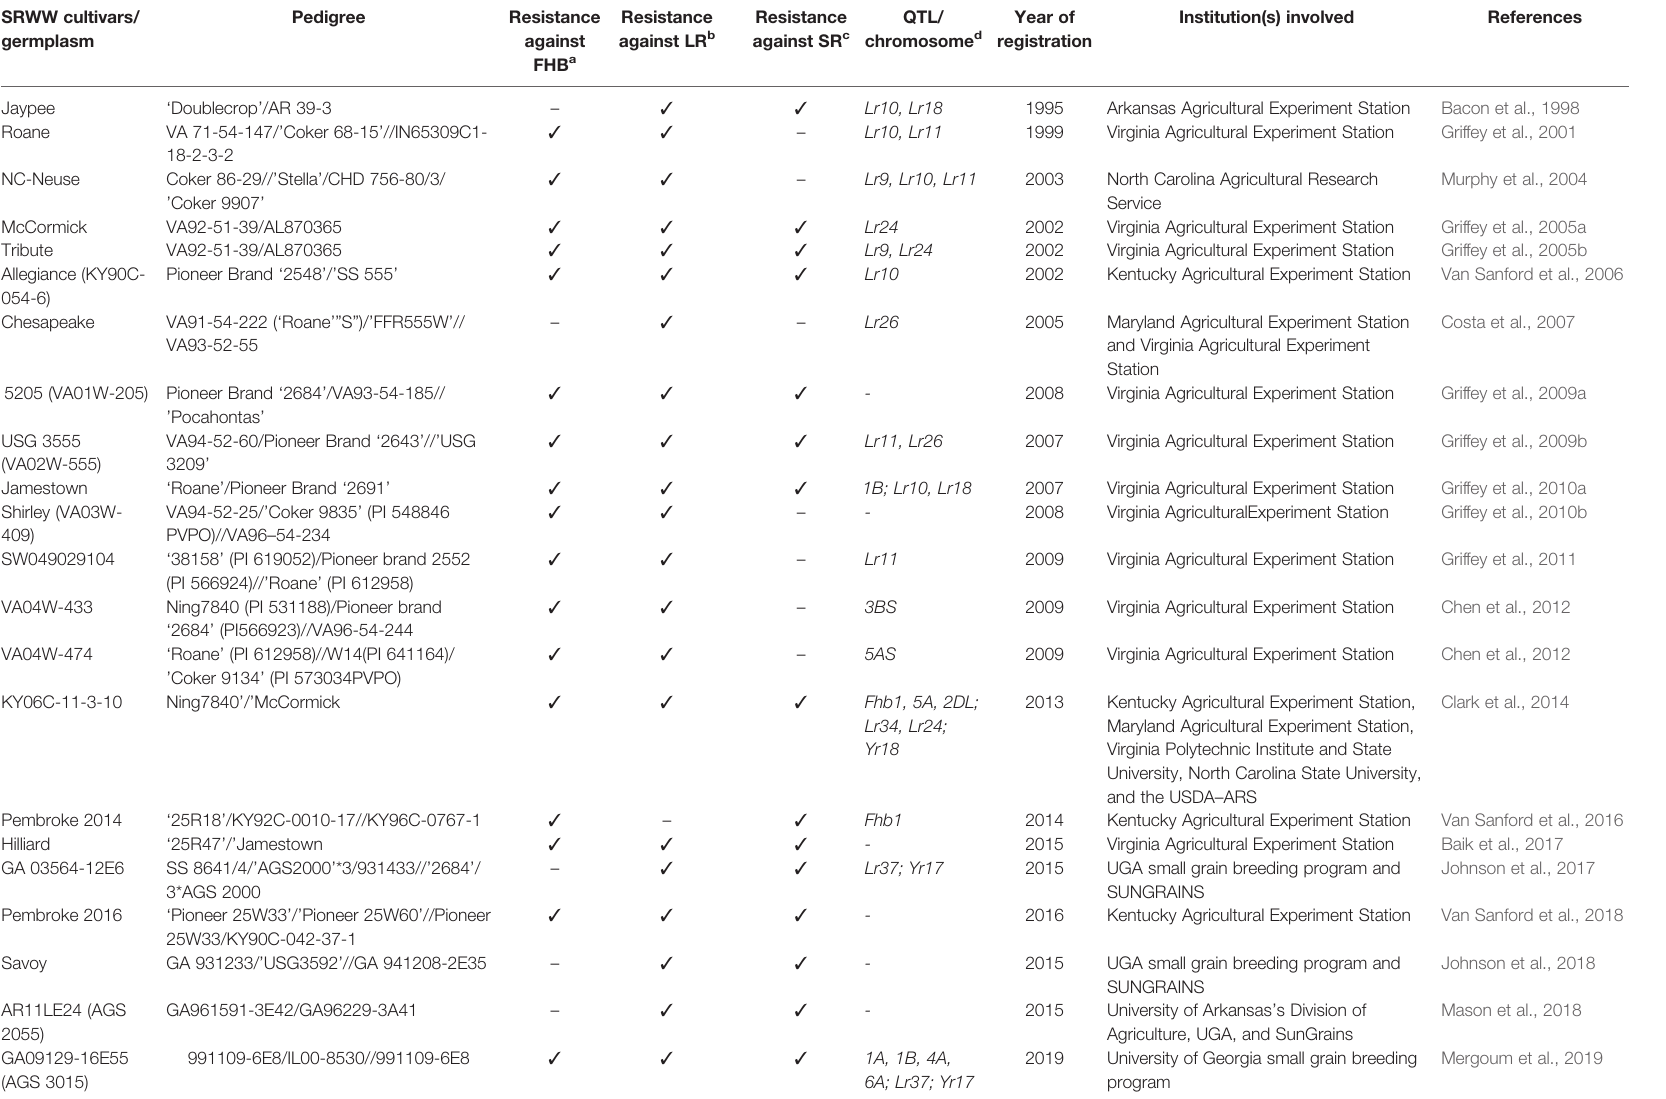
TABLE 3 | List of representative major FHB and rusts resistant SRWW cultivars/germplasm released in the southeast US. SRWW cultivars/